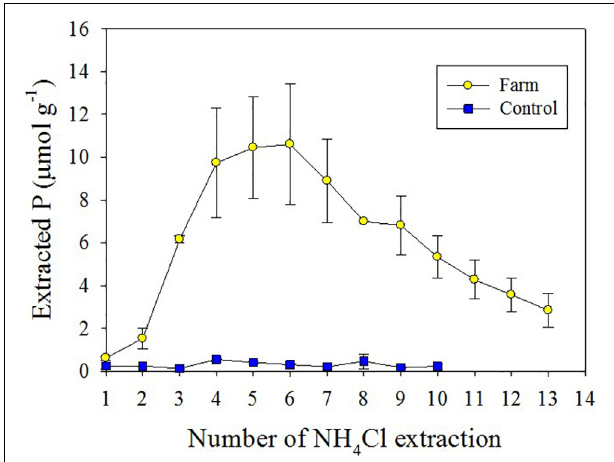
FIGURE 7 | Biogenic apatite P using NH 4 Cl extraction in farm and control